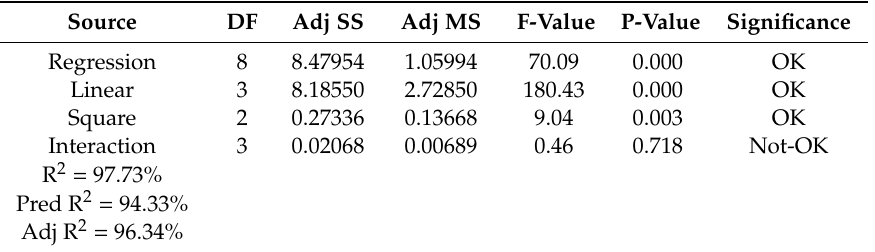
Table 6. ANOVA test result summary for checking the adequacy of the proposed model.